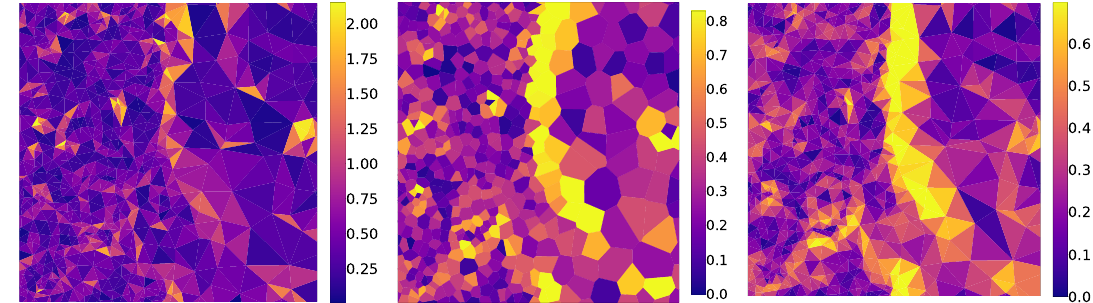
Figure 11 . Delaunay (left and right panels) or Voronoi (middle panel) triangulations of the data af- ter applying one Lloyd iteration, with individual cells color-coded by the magnitudes of their respec- tive rescaled gradient vectors computed from triangulation wombling (left panel), Voronoi-averaged according to eq. (3.9) (middle panel), or Delaunay-averaged according to eq. (3.10) (right